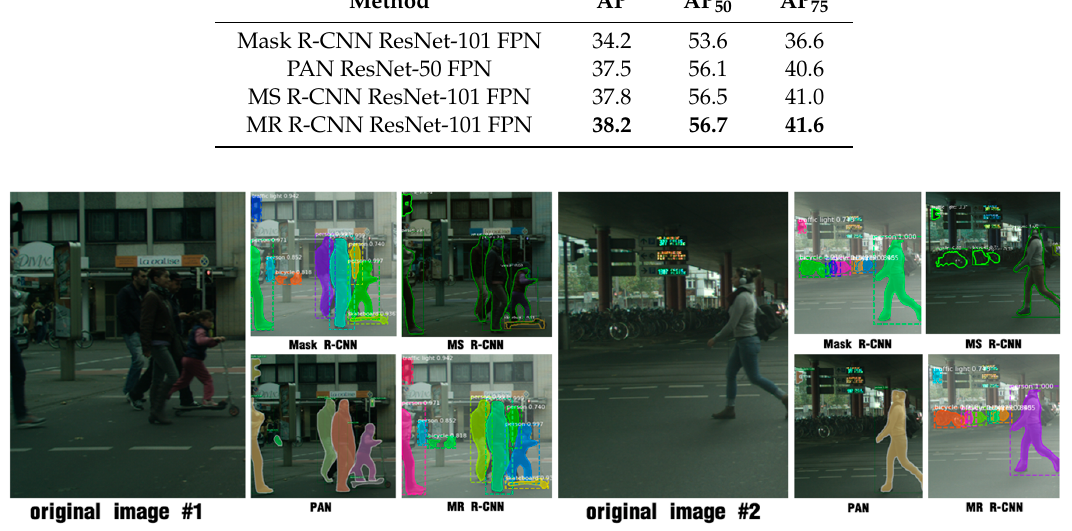
Table 3. Instance segmentation mask prediction results on 300 images from Cityscapes.